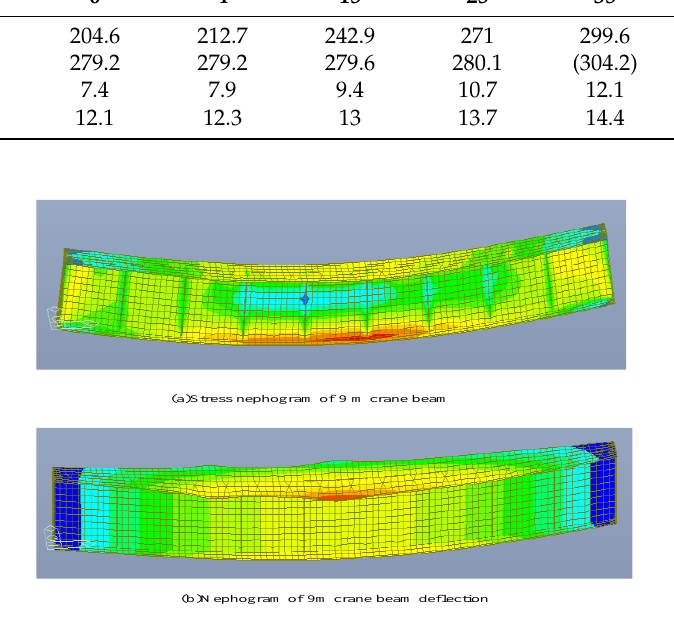
Figure 3. Construction of finite element model of 9 m crane beam.